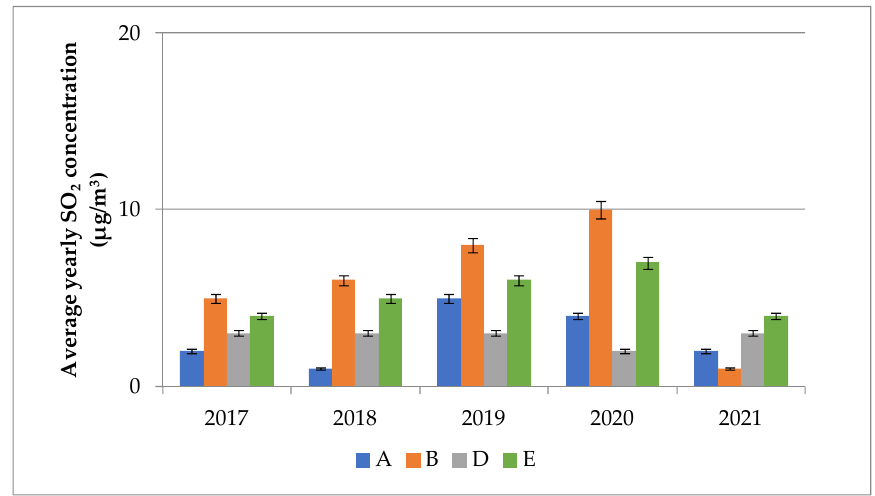
Figure 3. Average yearly SO 2 concentrations at locations A, B, D, and E between 2017 and 2021. Average annual SO 2 concentrations were the highest at location B (10.00 ± 0.50 µ g/m 3 ) in 2020, while the lowest were detected at location A (1.00 ± 0.05 µ g/m 3 ) in 2018. For location B, the average annual mass concentrations for the SO 2 parameter exceeded the critical limit value for vegetation protection (20 μ g/m 3 ) by five times in 2017, six times in 2018, eight times in 2019, ten times in 2020, and one time in 2021. For location D, the average annual mass concentration was exceeded by three times in 2017, 2018, 2019, and 2021, and two times in 2020. For location E, the average annual mass concentration was